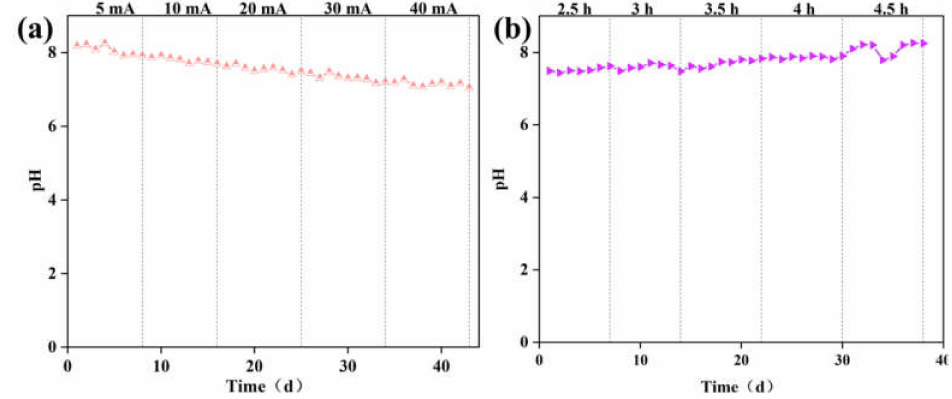
Figure 5. Variation of pH under different ( a ) Current intensities; ( b )